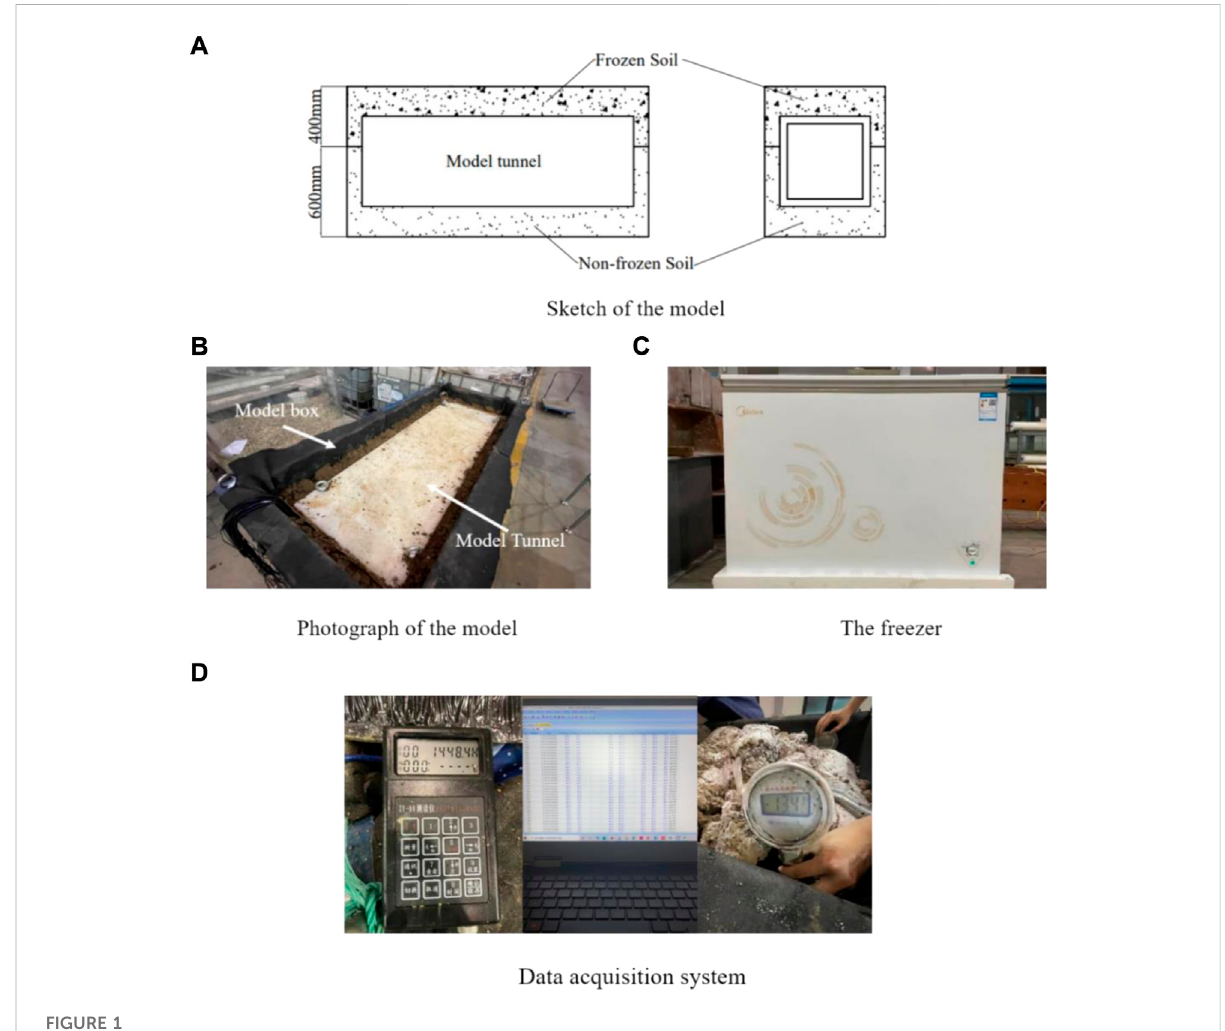
FIGURE 1 Test apparatus.